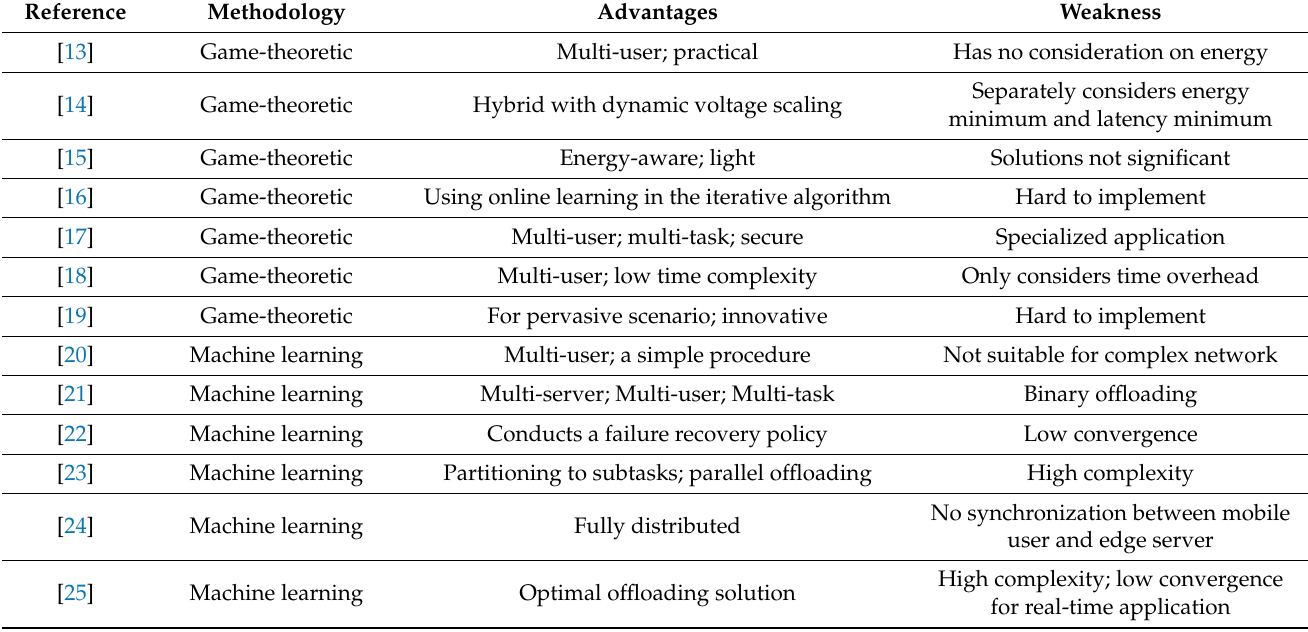
Table 1. The advantages and weakness of the works